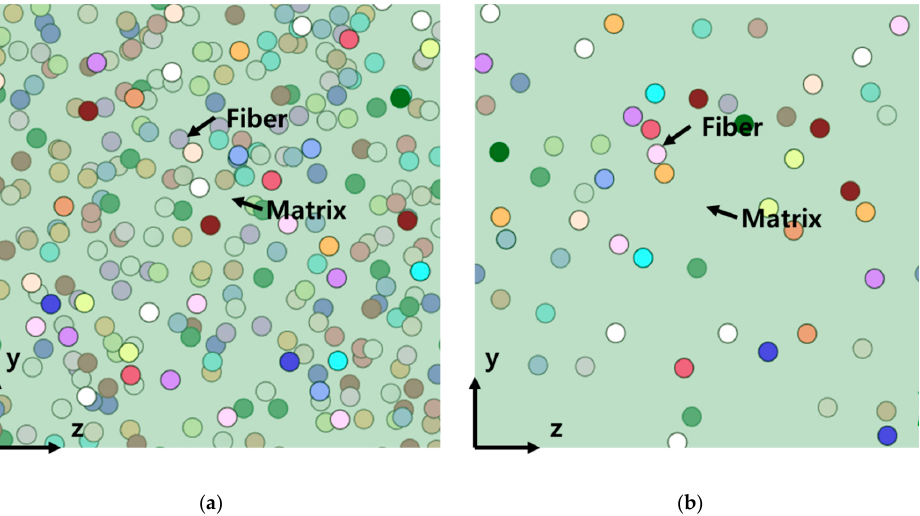
Figure 10. x–y cross section of the 3D model based on the volume fraction and aspect ratio, ( a ) VF5%—Aspect ratio 3, ( b ) VF5%—Aspect ratio 15. Aspect ratio 3, ( b ) VF5%—Aspect ratio